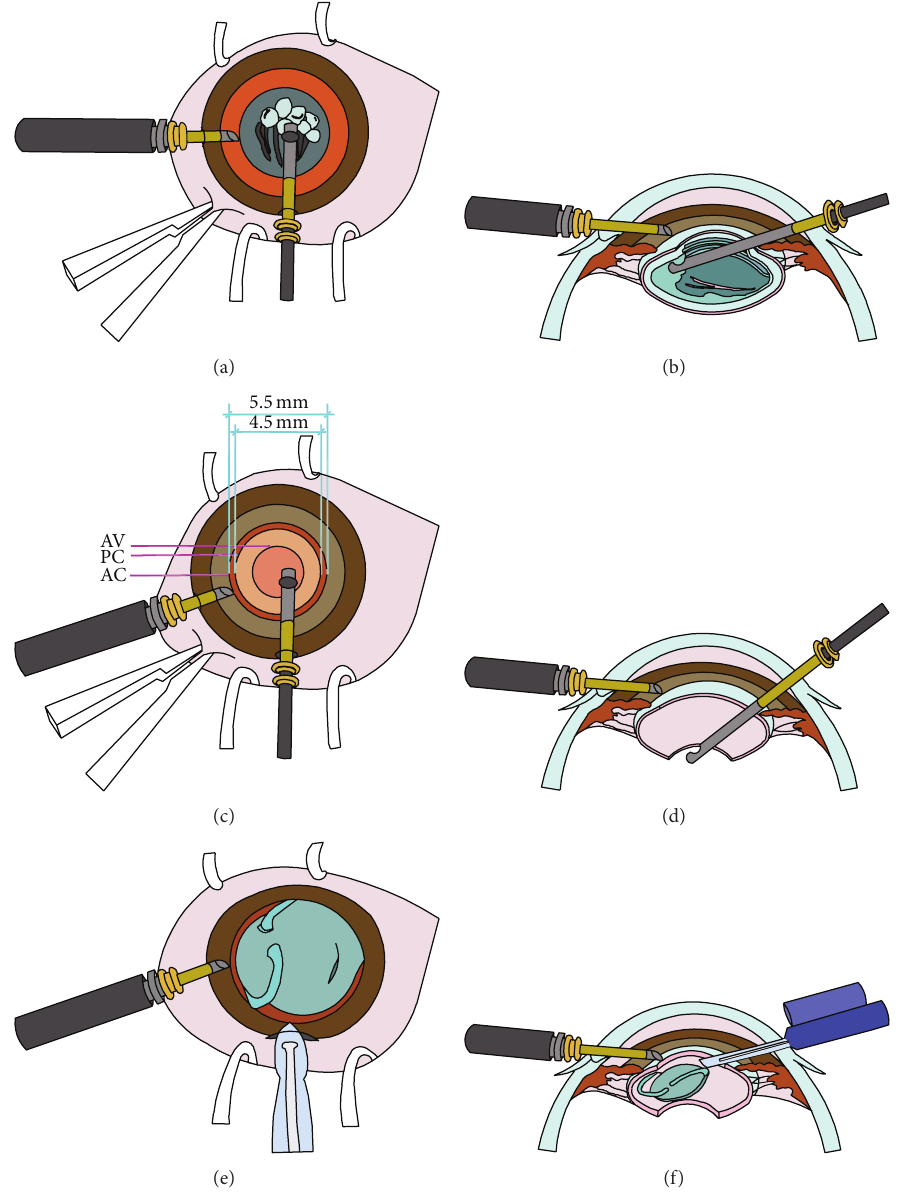
Figure 1: (a) Lensectomy was performed after a central anterior capsulotomy of 5.5 mm diameter using a 23-gauge vitrectomy cutter via a limbal incision. A limbal port incision was made for infusion to maintain the anterior chamber. The eye was positioned using a pair of forceps. (b) Cross-sectional diagram shows the lensectomy procedure. (c) Anterior vitrectomy after a posterior capsulotomy of 4.5 mm diameter. (d) Cross-sectional diagram shows the anterior vitrectomy procedure. (e) The 12 o’clock limbal incision was enlarged and a one-piece foldable IOL was implanted into the capsule bag. (f) Cross-sectional diagram shows the IOL implantation procedure (AV = anterior vitrectomy; AC = anterior capsulotomy; PC = posterior